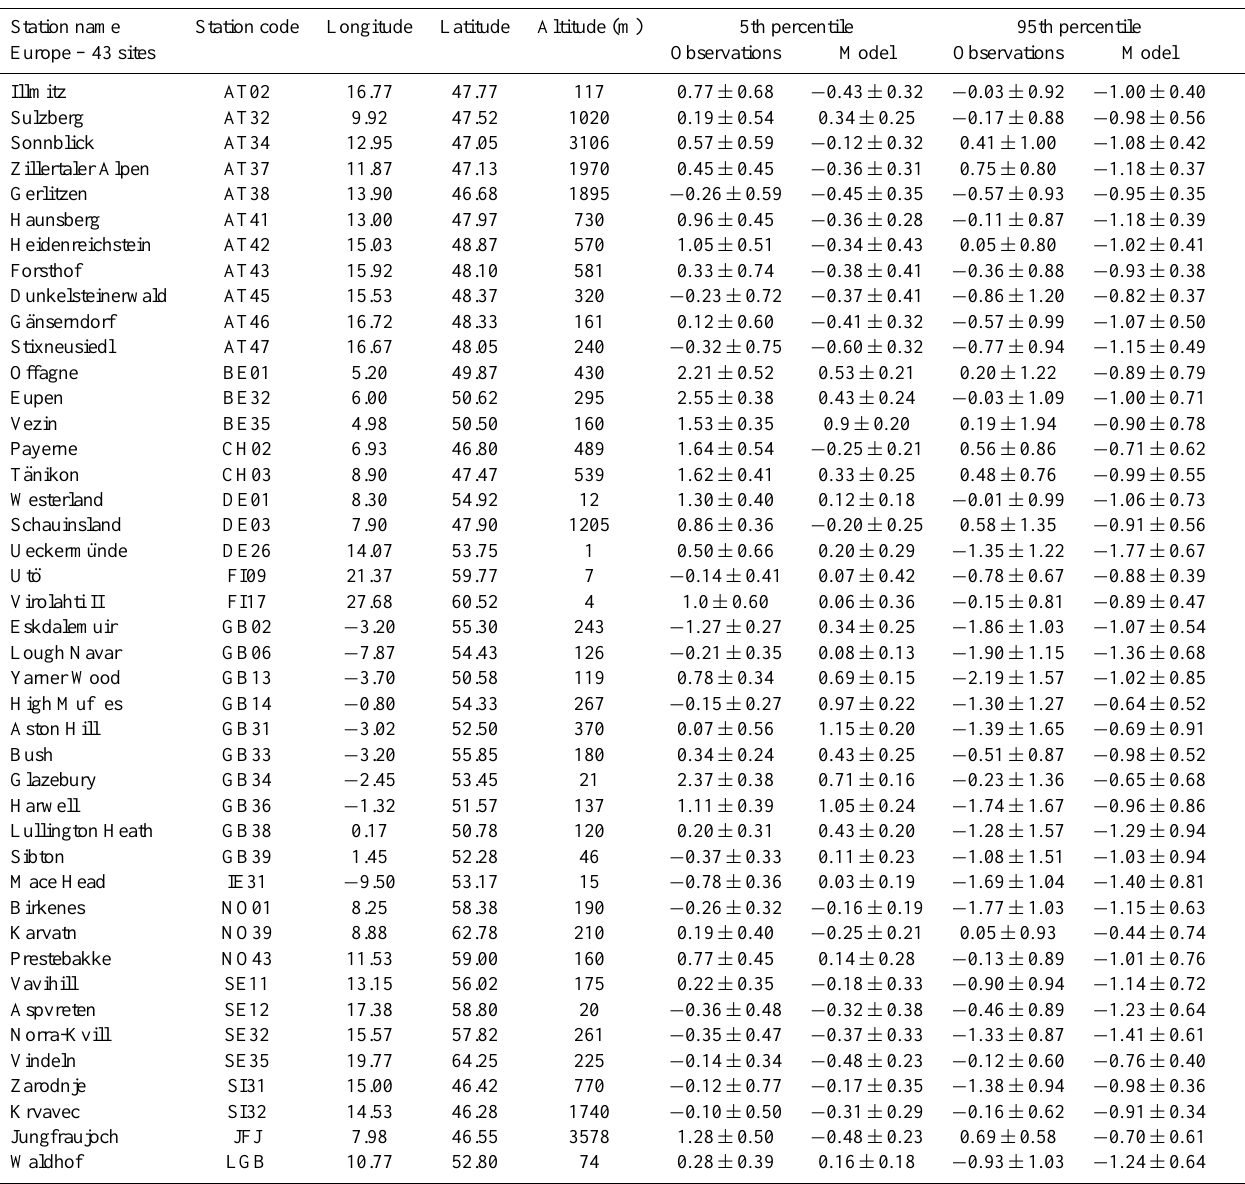
Table A1. Geographical information together with observed and simulated O 3 trend values (in ppb per year) for the 5th and 95th percentiles for each site studied in